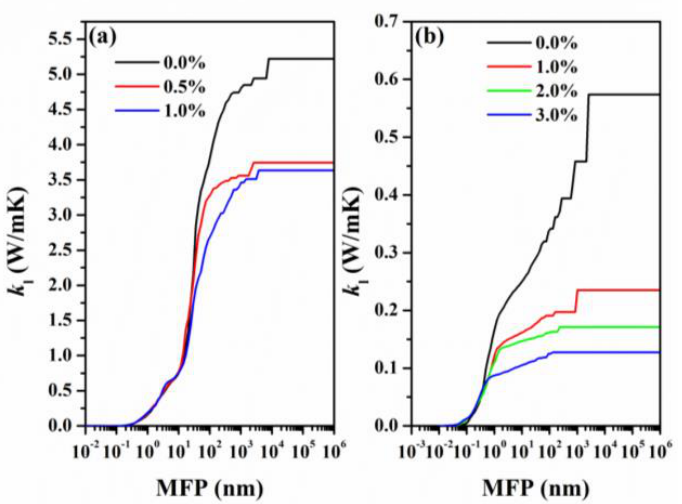
Figure 9. (Color online) The cumulative lattice thermal conductivity of ( a ) Se 2 Te and ( b ) SeTe 2 monolayers under tensile strains as a function of the phonon mean free path (MFP) at room temperature.